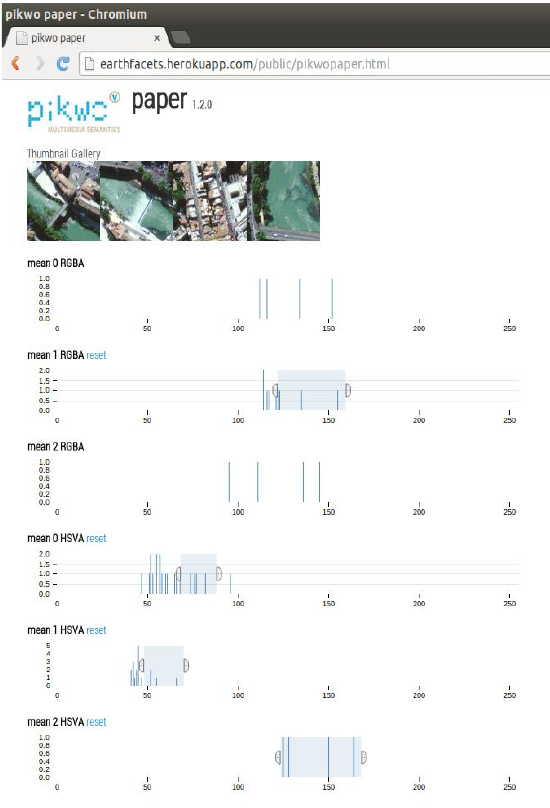
Figure 5: Search/Filtering results for class ”River”: image tiles are identified as highly luminous areas with significant satura- tion and strong green component. Note how selection operations have produced an update in both the image gallery and in the his- tograms.